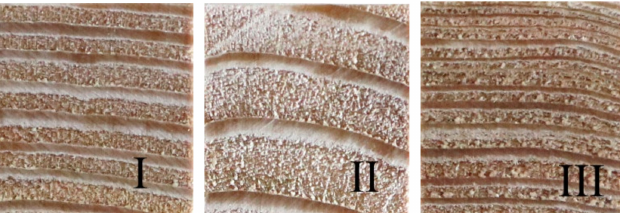
Figure 3. End face images of samples from three categories of larch wood: Type I (moderate ring width (RW), high latewood (LW) percentage); Type II (large RW, small LW percentage); Type III (small RW, small LW percentage).